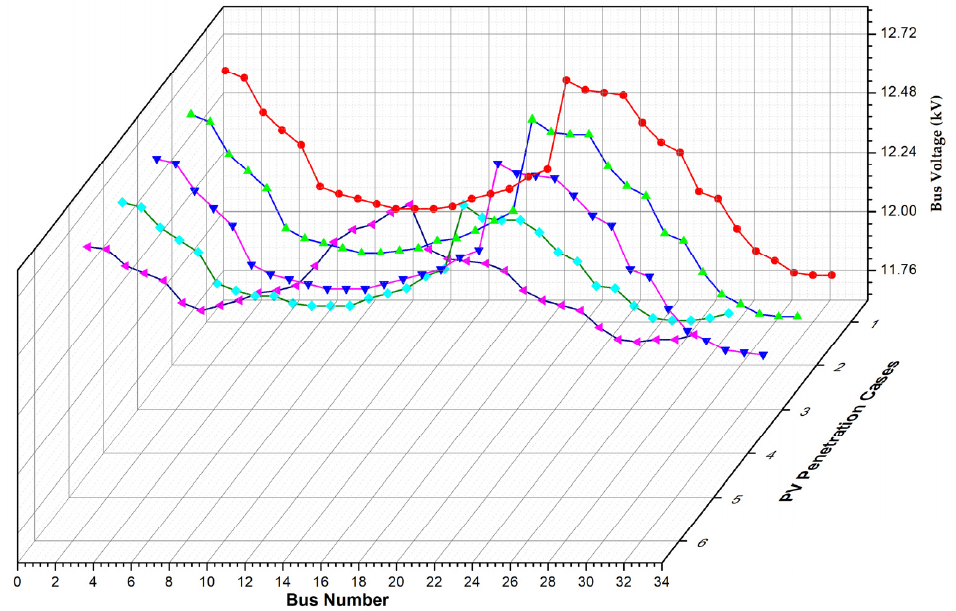
Figure 4. Bus voltage representation for all PV penetration cases.